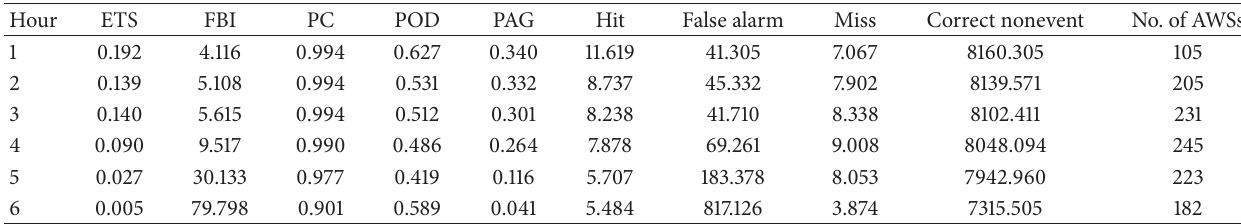
Table 8: Results of DE with SVM from 1 to 6hours (CE).